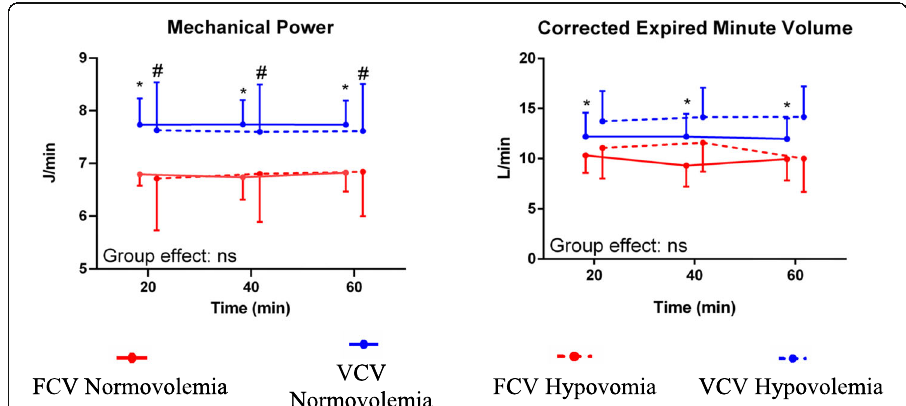
Fig. 3 Mechanical power and corrected expired minute volume. Symbols and vertical lines represent mean and standard deviation. Global statistical significance was accepted at P < 0.05. Differences between the two groups and the two ventilation strategies were compared using linear mixed-effects, repeated measures ANOVA. FCV = flow-controlled ventilation; VCV = volume-controlled ventilation; ns = not